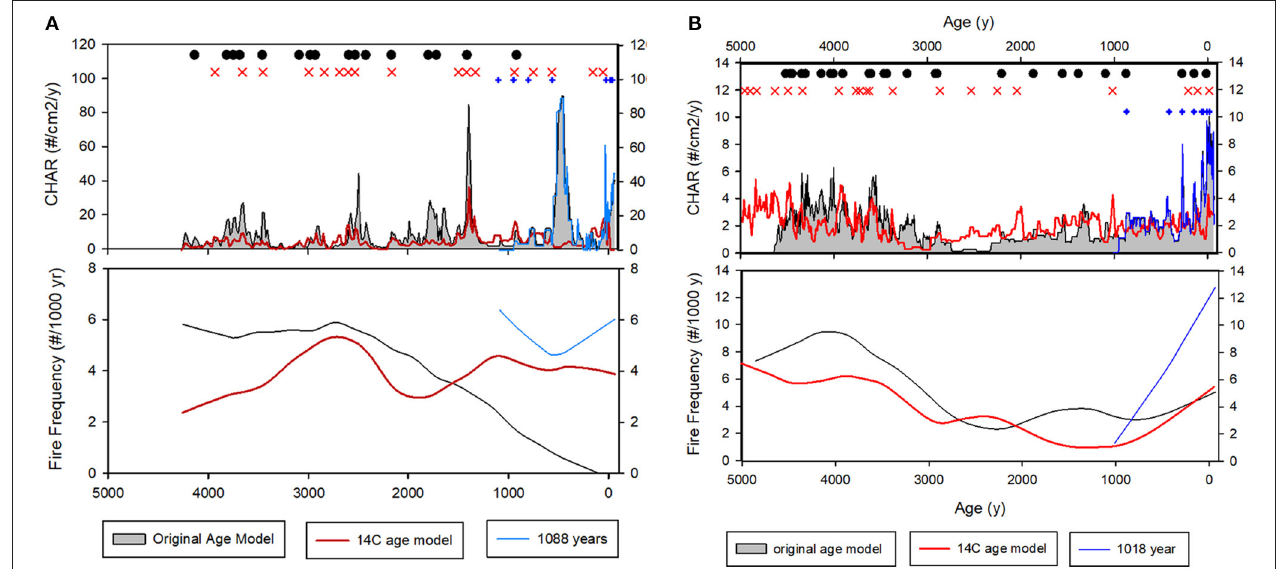
FIGURE 5 | Comparison of recent fire history characteristics between composite, AMS 14 C, and surface-only sedimentary-charcoal records for (A) Chadsey Lake and (B) Somenos Lake. For (A,B) , fire episodes are shown as black dots for the composite age records, red X for the AMS 14 C records, and blue plus symbols for the surface-only record. For CHAR and Fire Frequency composite records are black lines, AMS 14 C records are red lines, and surface-only sedimentary-charcoal records are blue